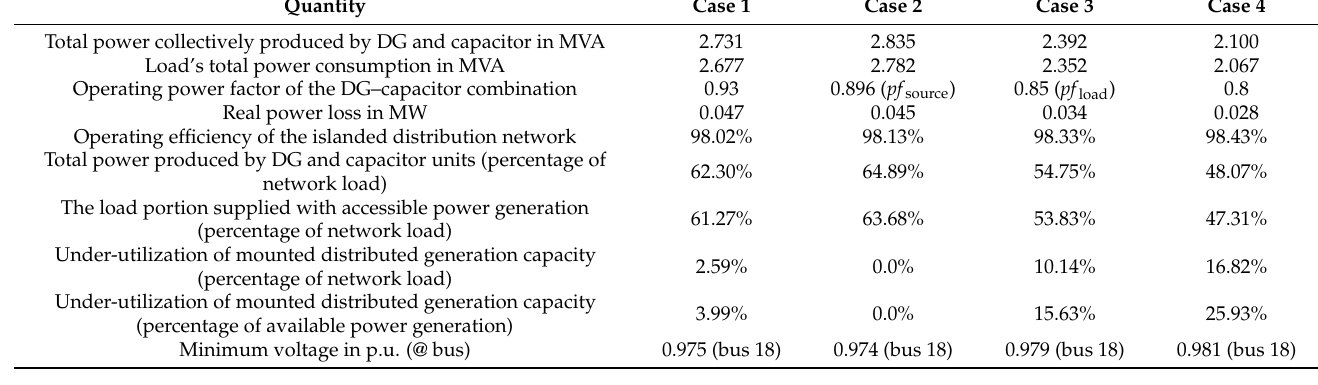
Table 3. Results for the 33-bus autonomous distribution network.